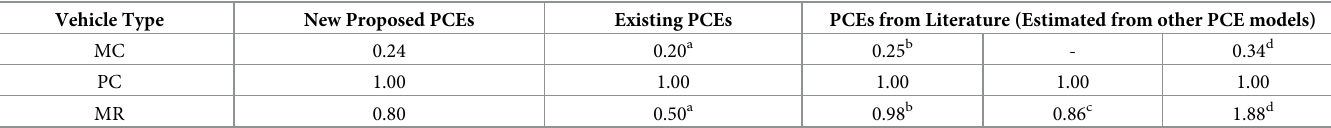
Table 2. Obtained PCEs value.